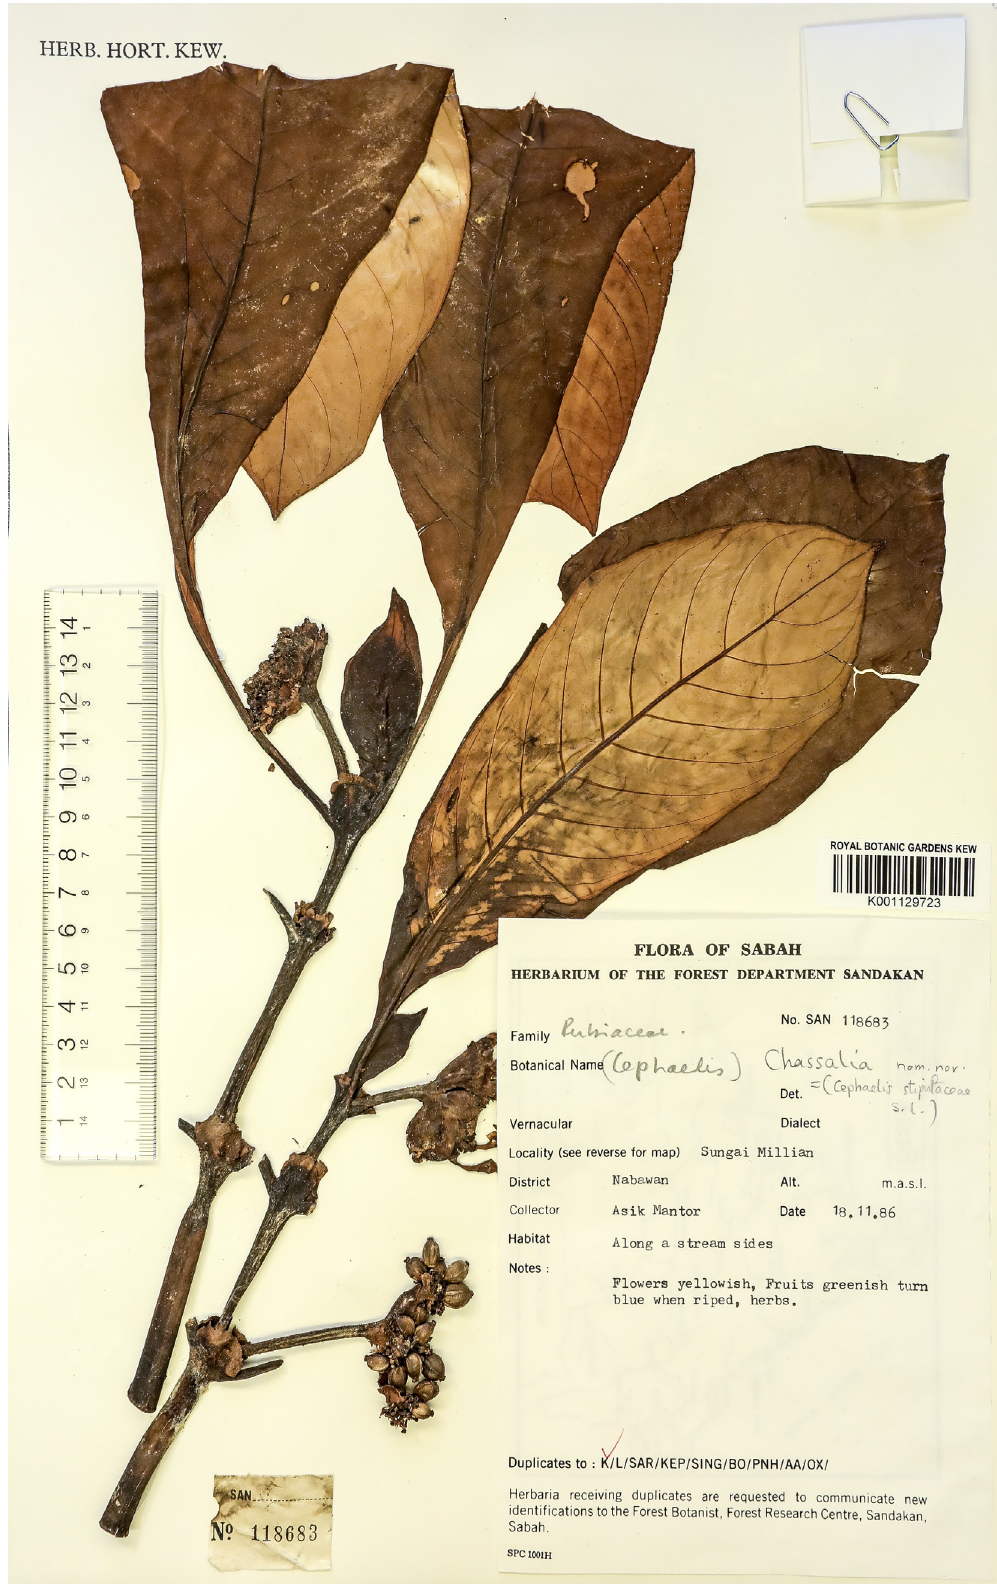
Fig. 9. Holotype of Chassalia calamus T.Y.Yu sp. nov. ( Asik Mantor SAN 118683